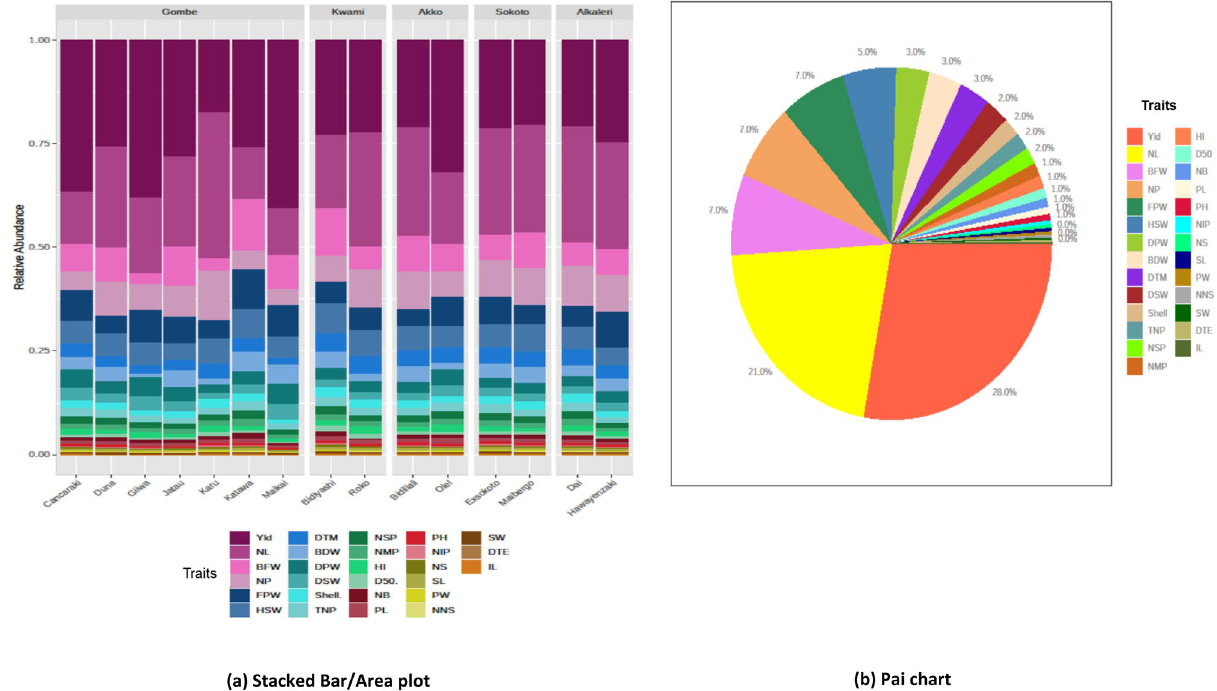
Figure 5. Relative abundance sketching: (a) stacked bar/area plot showing richness of traits in each genotype and (b) Pai chart showing the richness percentages with a unique color code for each Katawa (NB, BDW, BFW), Jatau (IL & D50%F), Bidiyashi (D50%F), Exsokoto (NNS & DTE), Bidillali (IL) and Maibergo (NS, Shell% & DTE), all other traits exhibits lower values are responsible for constructing different sub-groups among the genotypes. Interestingly, the groups and sub-groups in dendrogram 2 sharply highlighted the discrepancy effects of the diverse the Bambara groundnut landraces. Valuation of principal component analysis. Based on the results from Table 9 it appeared that the principal component 1 (PC1) accounted for close to 45.88% of the total variation and the characters responsi- ble for genotypes separation along this axis were TNP (highest 0.271), NMP, FPW, DPW, NSP, DSW, SL, HSW and YLD (kg ha −1 ) with high and positive value of coefficient of variation. The second principal component (PC2) associated with the traits D50%F, PH, NP, NL, FPW, DPW, DSW, HI (maximum 0.447) and YLD (kg ha −1 ) accounted for 10.64% of the total variation. About 8.78% of the total variation was detected for Principal Component 3 (PC3) and displayed differences based on PH, NB, NS, NP, NL, NNS, IL (largest 0.472), BFW and BDW. The principal component 4 (PC4) accounted for 8.19% of the total variation and consisted mostly of the traits of D50%F, NS, NP, NL, HSW, and Shell% (maximum 0.444). The variation (6.75%) was found for principal component 5 (PC5) and comprised with D50%F (maximum 0.479), DTM, DSW and YLD (kg ha −1 ). The last principal component 6 (PC6) accounted for 5.69% of the total variation and consisted of the traits DTE, DTM, NP, NL, BDW, NIP, PW and SL up to this principal component covered close to 86% of the cumulative variation. The two-dimensional (Fig. 8a) and three dimensional (Fig. 8b) graphical elucidation demonstrated that most of the accessions were dispersed at low distances whereas the few were dispersed at high distances as reflected by eigenvector (Table 9). The farthest accession from the centroid was G2, G3, G8, G9, G12 and G13 whereas other accessions were near to centroid. The proportion of variation for principal component (PC1) and (PC2) were 45.88% and 10.64% respectively, in which the first principal component occupied the topmost position of the total variation existed (Table 9). PCA biplot loaded the both variables and cases (accessions) at the same time shows how strongly each trait influences a PC and correlated to each other it also shows the how distances the genotype from each other. The lesser angle between two vectors (Fig. 9) indicate higher and positive correlation (e.g. DSW & Yield), when angle between two vectors form 90° indicate no correlation while it goes more than 90° to near 180°, indicate negative correlation between the traits (e.g. HSW & NL) . Valuation of Shannon–Weaver diversity (H’ Index). The Shannon–Weaver diversity index was used to assess the phenotypic diversity for each trait. The estimation of the Shannon–Weaver diversity index (H) and Evenness (E H ) for the twenty-seven traits shown in Table 9. The Shannon–Weaver diversity index ranged from 2.57 for dry seed weight per plant to 2.71 for plant height, maturity date and shelling percent including the traits like fifty percent flowering date, nodes number per stem, internode length, pod width, seed length and seed width which indicated that maximum diversity (H = 1.70) was present among these traits. The equitability or evenness was found varied from 0.95 to 1.00. Similarly, maximum (E H = 1.00 ) values of evenness was marked for the traits like fifty percent flowering date, maturity date, plant height, nodes number per stem, internode